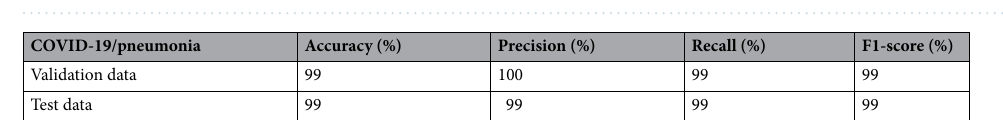
Figure 6. Model VGG16 for COVID/normal on X-ray dataset.